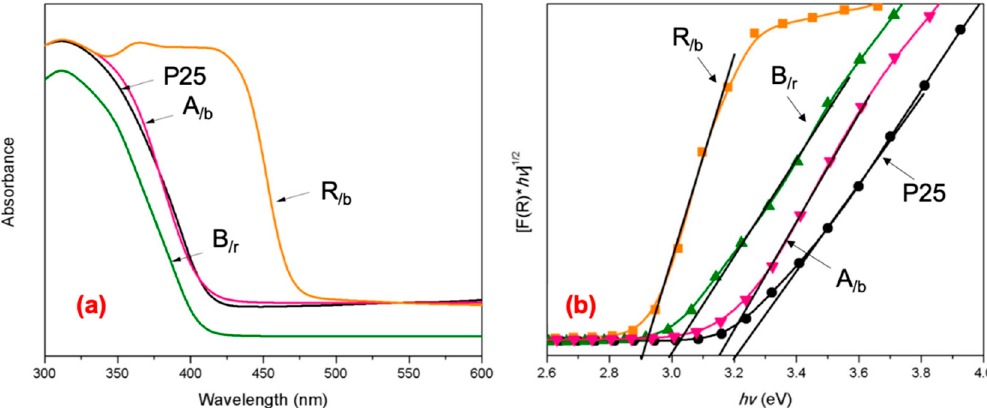
Figure 5. ( a ) UV-Vis absorbance spectra and ( b ) Tauc plots showing the band gap energies of the synthesized mixed-phase nanoTiO 2 photocatalysts.